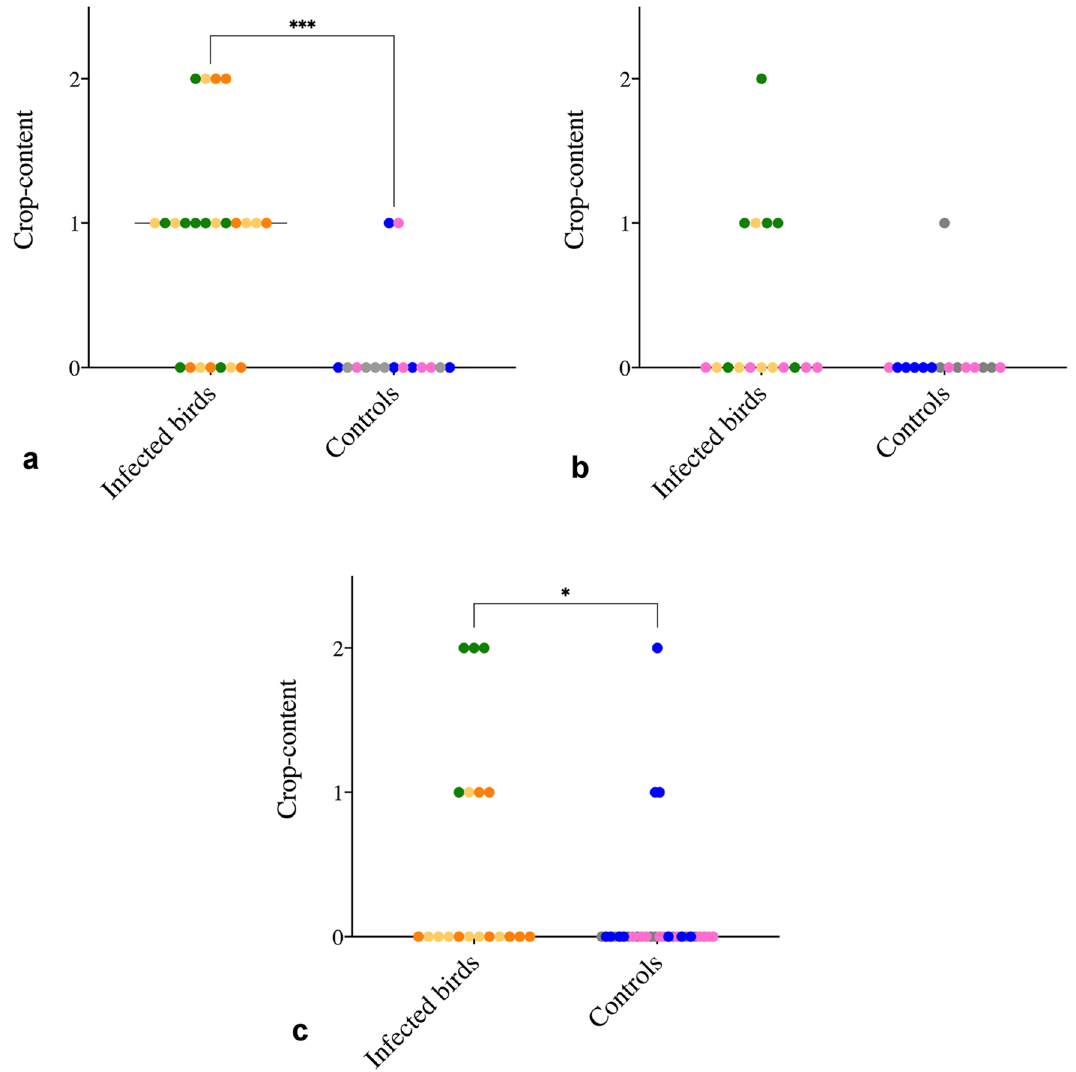
Figure 5. Post-mortem crop-content. Crop-content score in E. coli -infected birds vs vehicle-receiving controls at ( a ) 2 dpi, ( b ) 4 and 5 dpi, and ( c ) 6 and 7 dpi. Green, yellow and orange dots represent IT, Aerosol_1 and Aerosol_2, respectively, whilst IT_control is presented with grey dots, Control_1 by pink and Control_2 by blue dots. The absence of palpable content within the crop was graded as 0, presence of noticeable content as 1, and a filled crop as 2. Data is presented with the median and was analysed using a Mann–Whitney test. * p = 0.0269, *** p = 0.0008. dpi days post-infection; IT